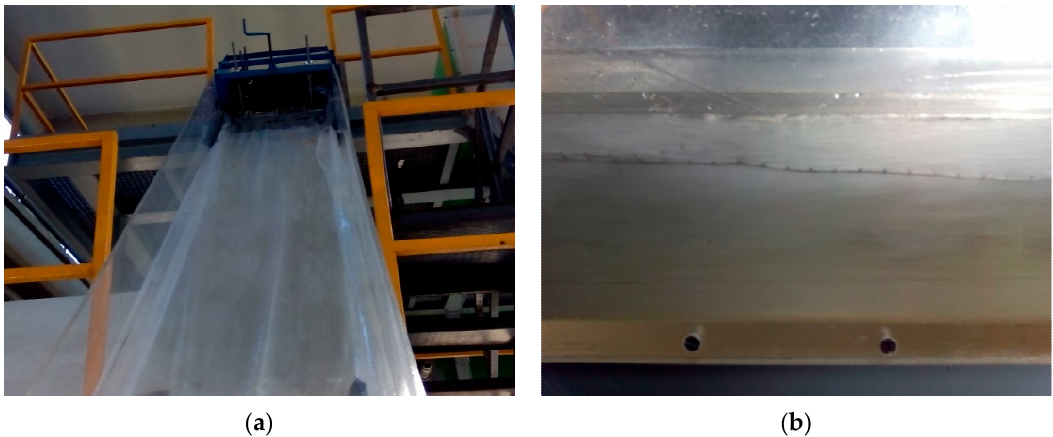
Figure 6. Boundary conditions over the flow surface during the experimental analysis: ( a ) Plastic cover to reduce air exchange between flow and atmosphere; ( b ) Effects of the metallic mesh and plastic cover over the flow in the test.